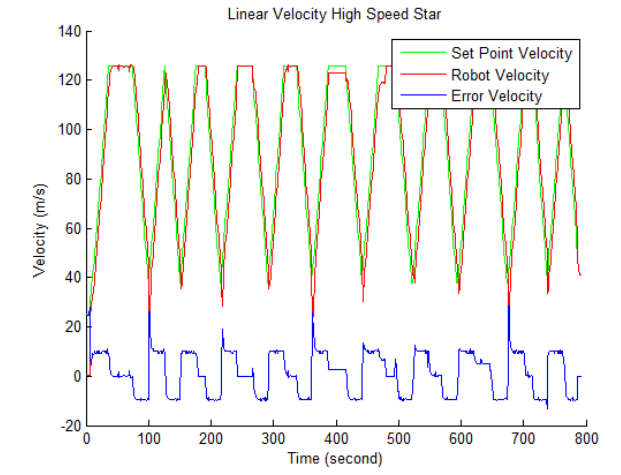
Figure 24. High-speed Performance in Linear